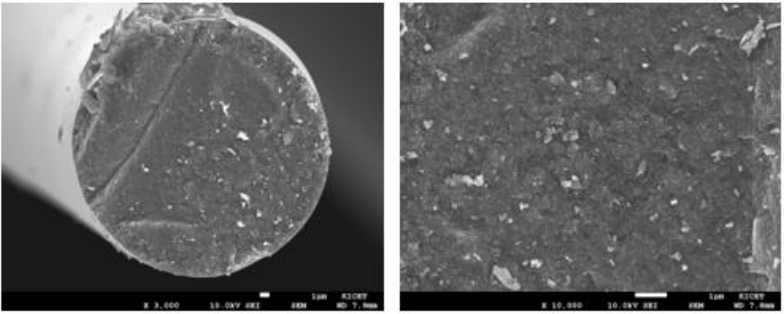
Figure 9. The cross-sectional SEM images of the polycrystalline Si-Al-C-O fibers fabricated via the control of impurity contents.